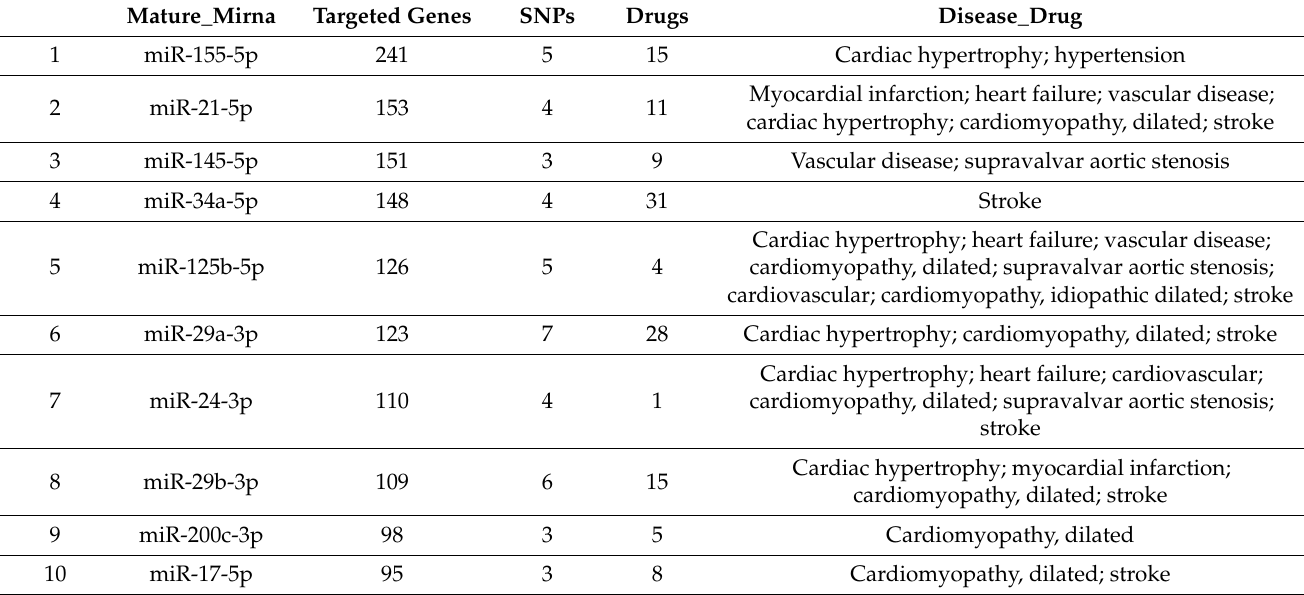
Table 1. Top 10 miRNAs implicated in